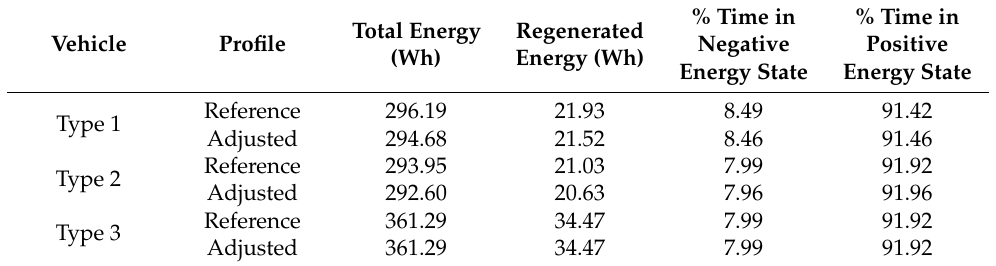
Table 4. Energy-related summary statistics of adjusted drive cycles (WMTC Cycle 1).